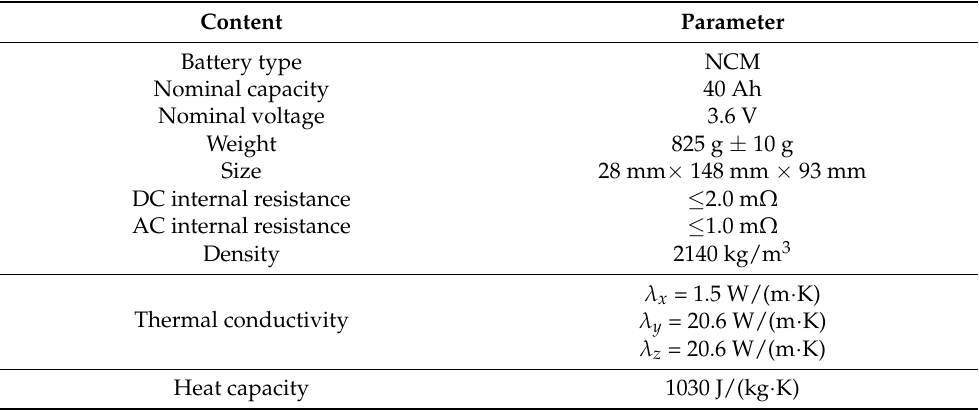
Table 1. Battery